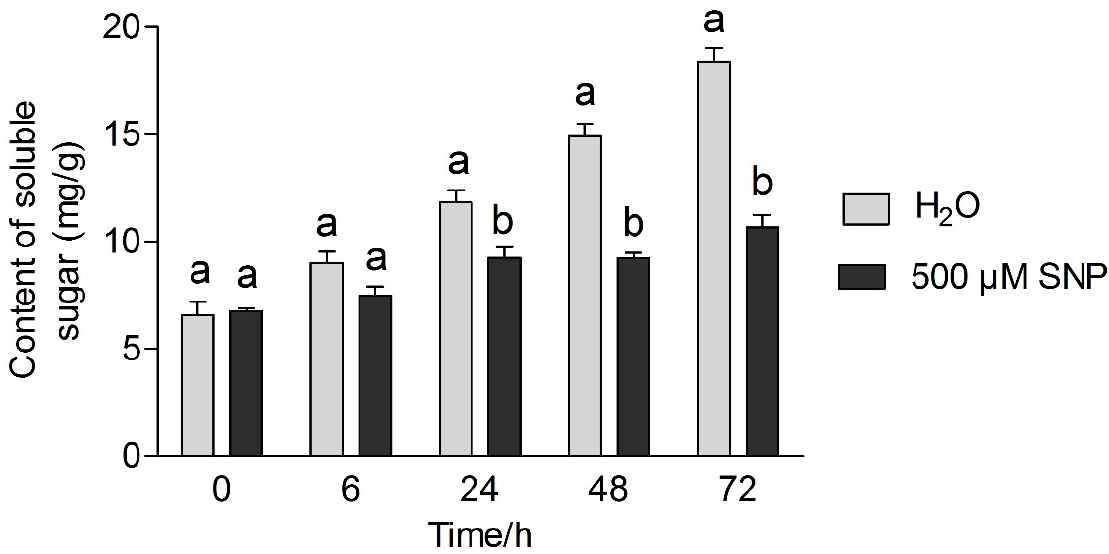
Figure 5. Effect of exogenous nitric oxide on soluble sugar content in tea leaves under cold stress.